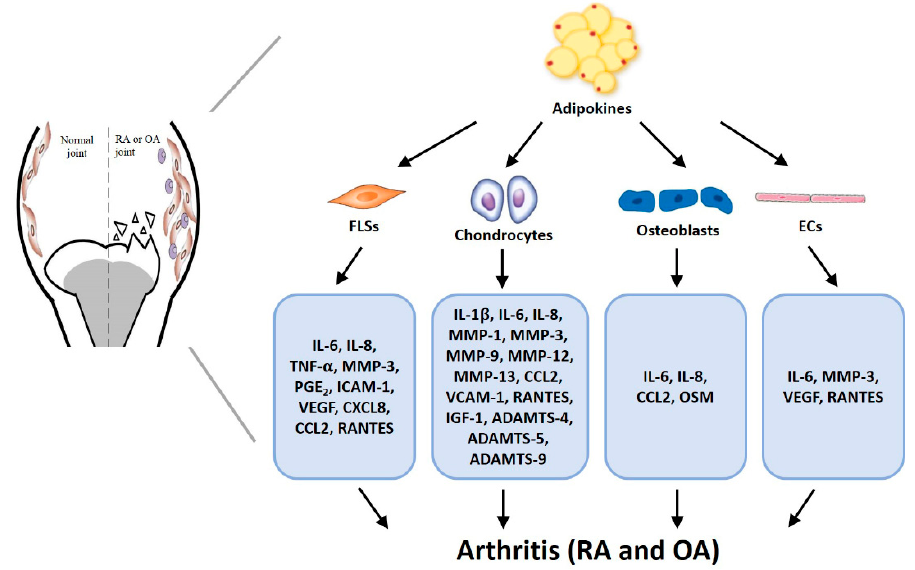
Figure 2. Critical pathways involving adipokines in arthritic diseases. Adipose tissue paracrine signaling in RA and OA demonstrates systemic links between adipokines and arthritic disease.